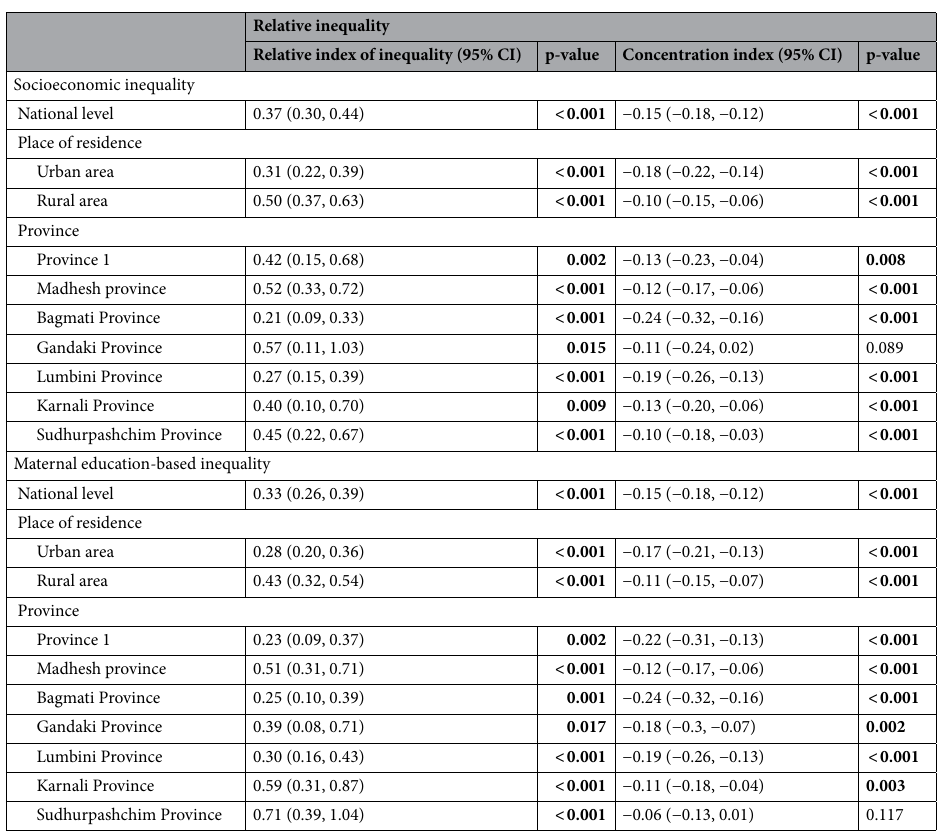
Table 2. Socioeconomic and maternal education-based inequality in the prevalence of suspected developmental delays among Nepalese children (N = 2870). CI confidence interval. Significant values are in